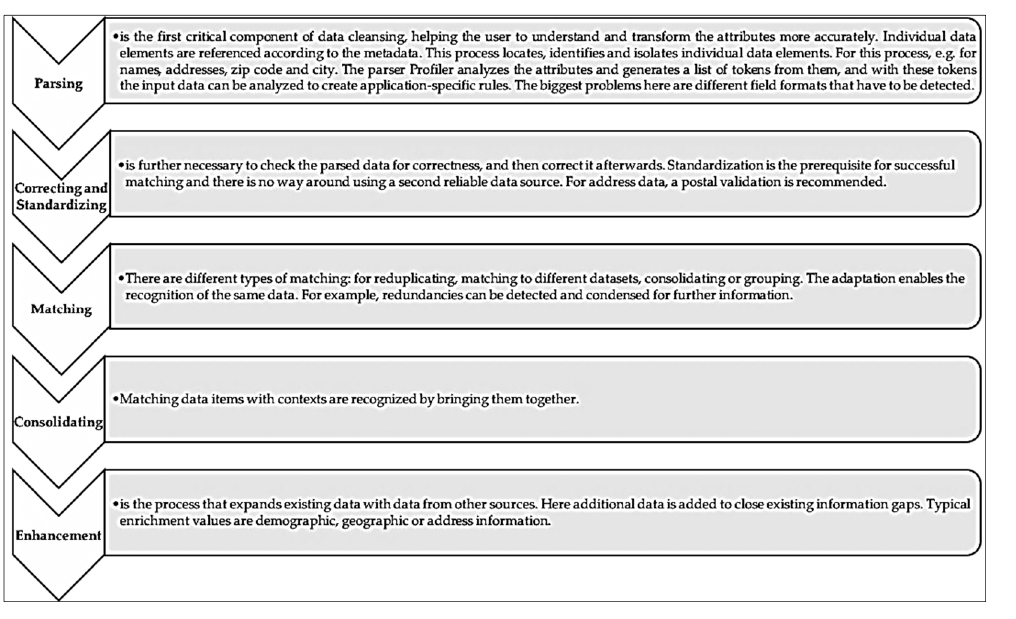
Figure 9. Data cleansing processes.